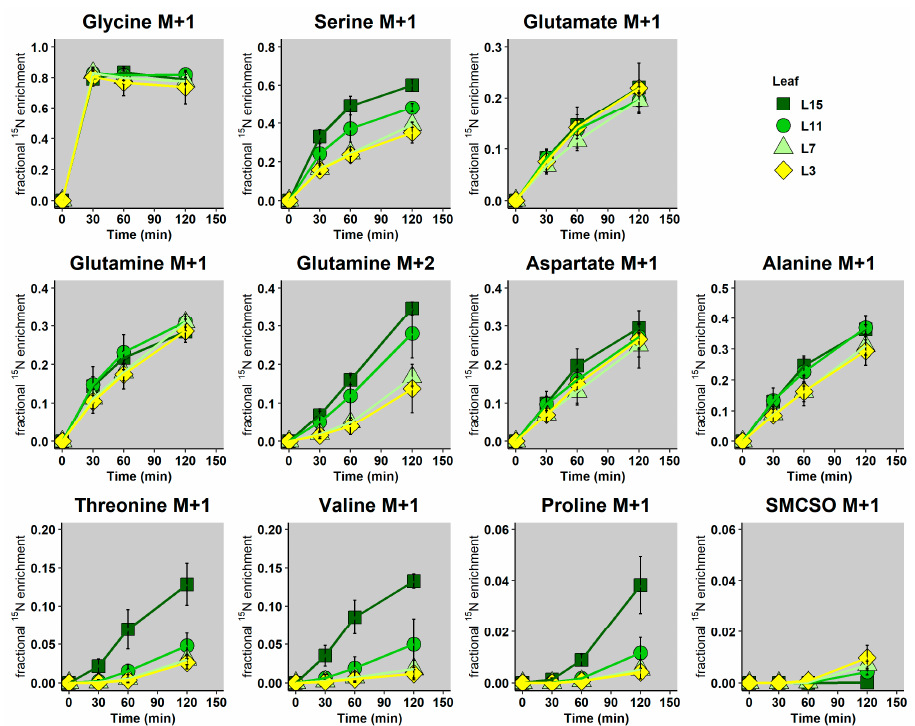
Figure 4. Time-course fractional 15 N enrichment of the most abundant amino acids in leaf ranks having a different sink/source balance during an instationary labeling experiment with [ 15 N] L -glycine as sole nitrogen source. Leaf discs from the four leaf ranks having a different sink/source balance were floated during 0, 30, 60 or 120 min in a buffer containing 10 mM [ 15 N] L -glycine, under continuous light and orbital shaking. Analysis of nitrogen isotopologue distributions within amino acids was achieved with a HPLC-HRMS system. Values are the mean ± SD of 3 independent biological replicates for each leaf group and each kinetic. The complete dataset is available in Supplementary Table S3.